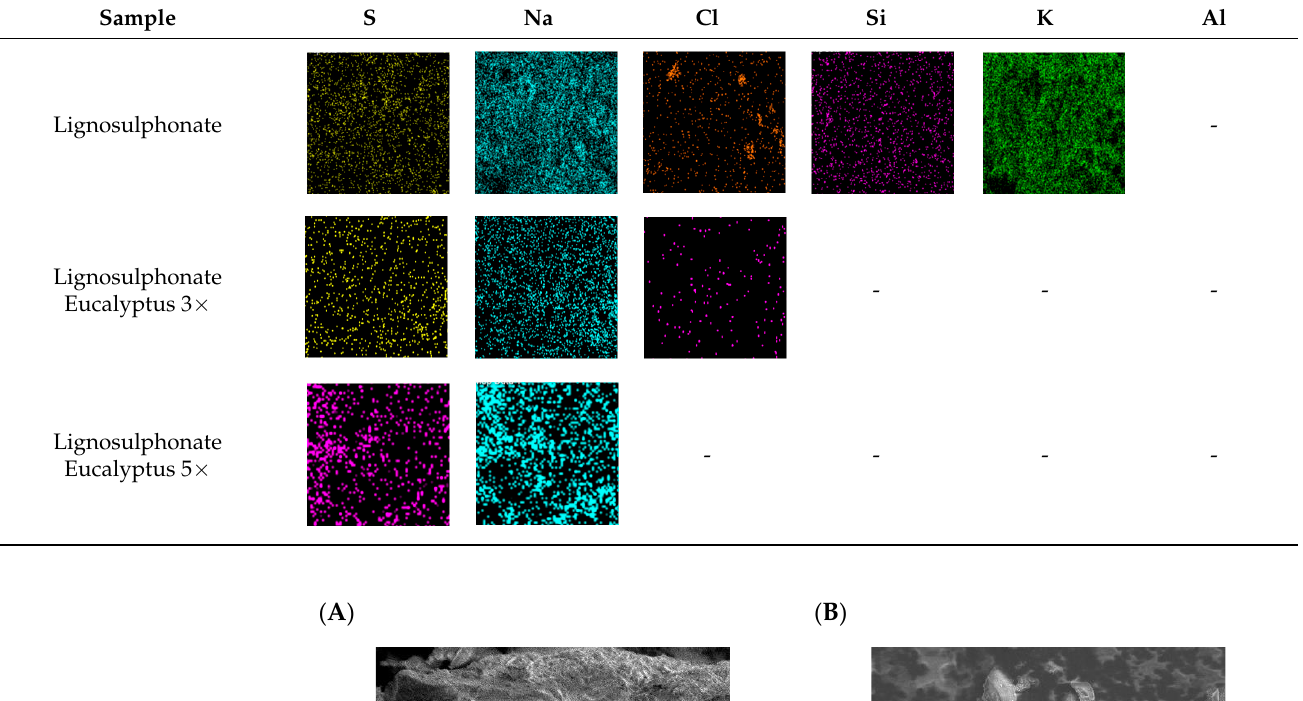
Table 6. Chemical constituent elements with FESEM EDX.